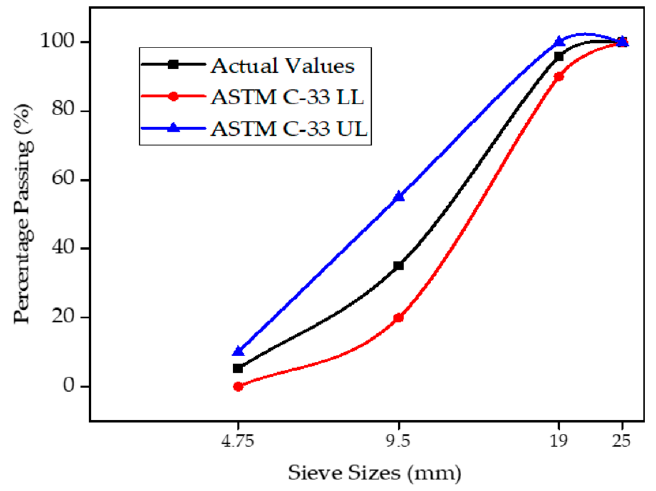
Figure 2. Particle size distribution curve of coarse aggregate in line with ASTM C-33 limits.